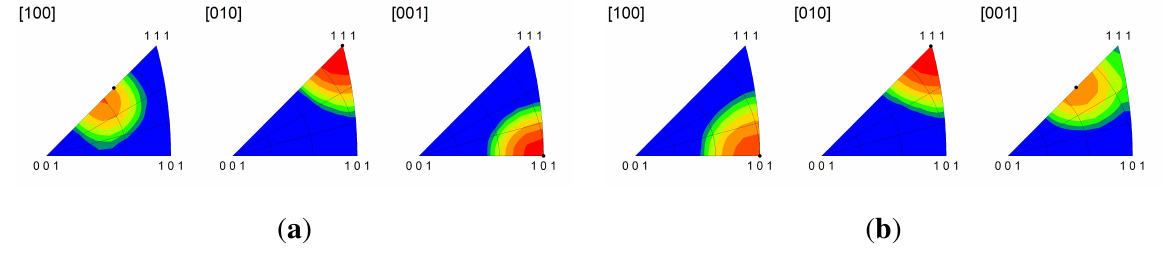
for the ( a ) copper phase in the Brass-I interface; and ( b ) niobium phase in the Brass-I interface.